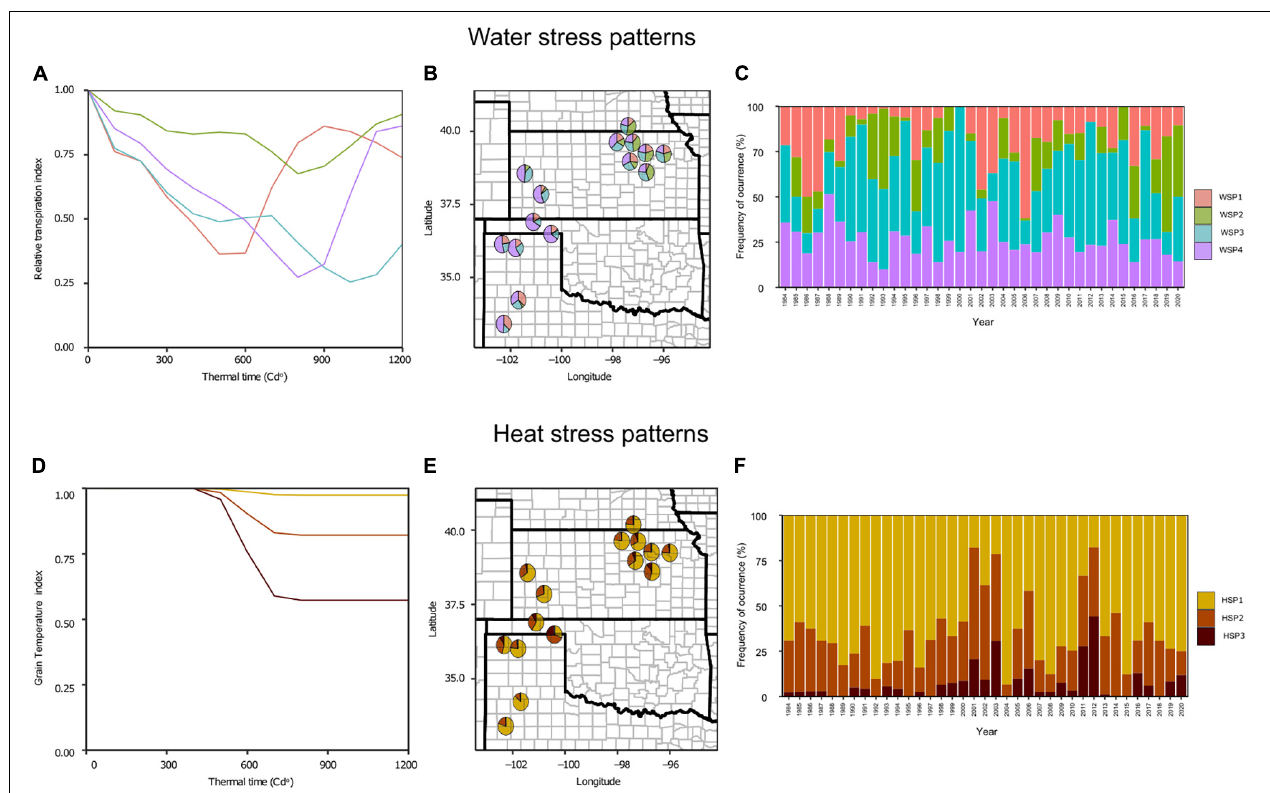
FIGURE 2 | (A,D) Relative transpiration (RT) index (A) and grain temperature (GT) index (D) throughout the crop life cycle expressed in thermal time units for the identified patterns. Water stress patterns (WSP): WSP1, in green is a low water deficit condition; WSP2, in red is a preflowering water deficit condition; WSP3 in blue is a grain filling water deficit condition with no recovery at the ends of the crop life cycle; WSP4 in purple is a grain filling water deficit condition with recovery at the ends of the crop life cycle. Heat stress patterns (HSP): HSP1, in yellow is a low heat stress condition; HSP2, in orange is a moderate heat stress condition; HSP3 in dark red is a severe heat stress condition. Each line represents the index average for the seasons clustered under the same group. The RT and GT values go from 1 to 0, with 1 representing a no stress condition and 0 a complete stress condition. (B,E) United States Great plains map with the WSP (B) and HSP (E) frequencies are represented as pie charts. The pie charts are placed in the trial sites for the model evaluation. (C,F) Frequency of the occurrence of the different WSP (C) and HSP (F) over 36 years of climatic data for the whole studied